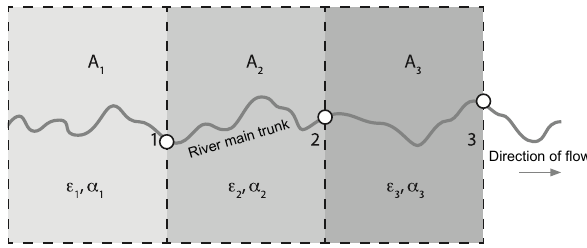
Figure 2. Schematic representation of how the landscape is divided into exclusive contributing areas A i (different shades of gray) for each of the points (here the circles labeled i = 1 ,..., 3) along the main river where we have age distributions. (cid:15) i and α i are the as- sumed mean erosion rate and mineral concentration factor of Area i ,